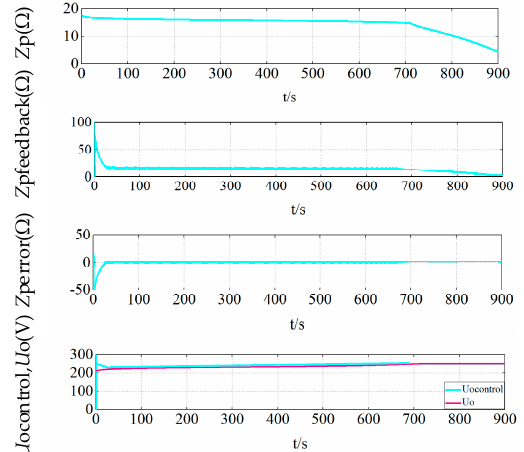
Figure 11. The diagram of closed loop control.